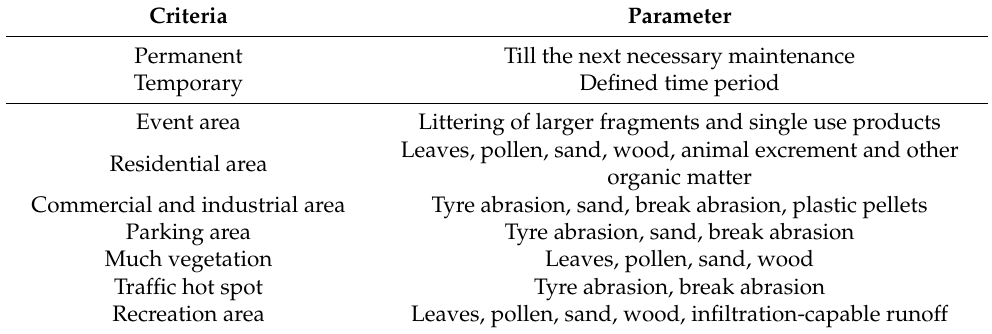
Table 1. Criteria of use case scenarios.